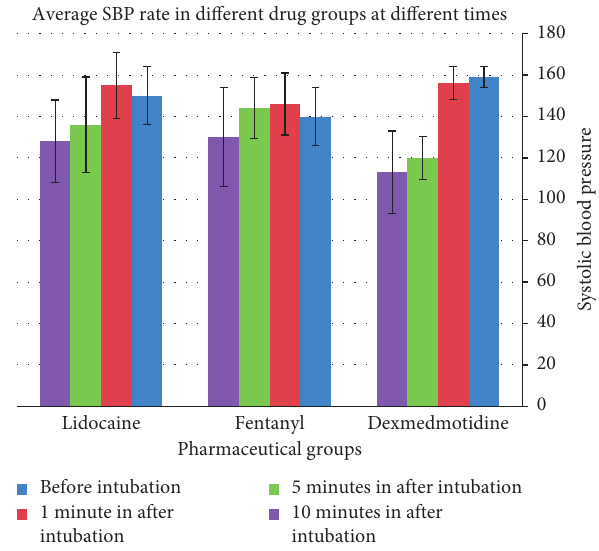
Figure 3: Comparison of SBP in the 1st, 3rd, 5th, and 10th minutes after intubation with before intubation in each group.